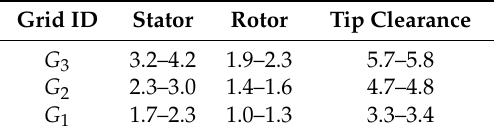
Table 2. Range of the surface-averaged y + , Q = 0.35 m 3 /s–0.471 m 3 /s.